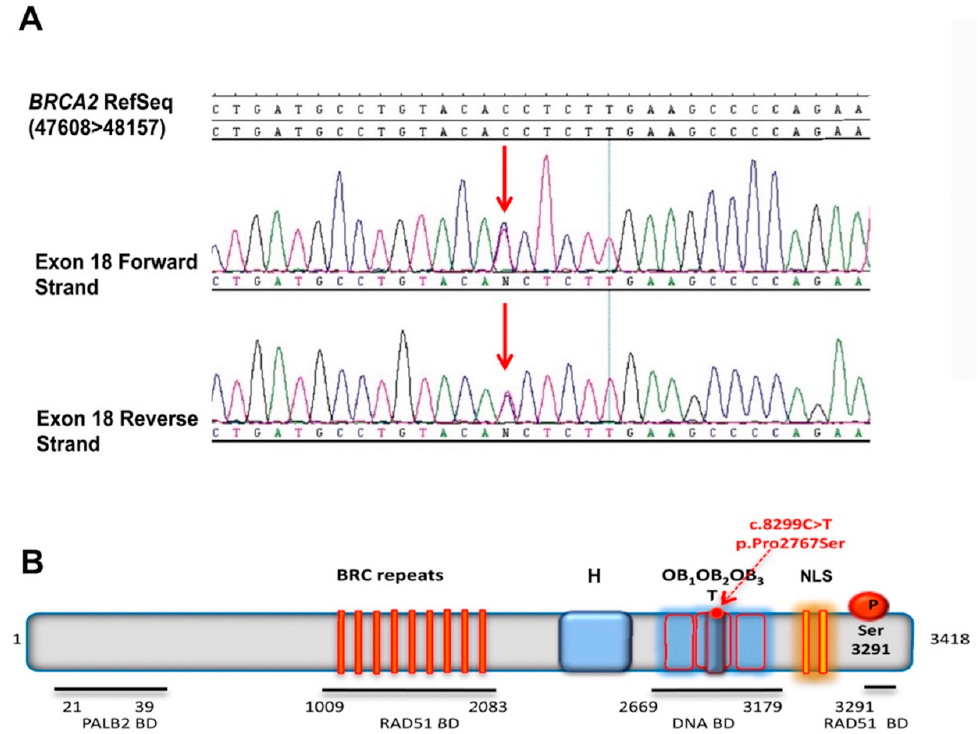
Figure 1. Sanger sequencing of the exon 18 of BRCA2 and BRCA2 full-length protein representation. ( A ) Sanger sequencing of the exon 18 of the BRCA2 gene performed on the patient’s DNA showing the c.8299C > T p.Pro2767Ser variant in the heterozygous state on forward and reverse strands. ( B ) Schematic representation of the full-length BRCA2 protein (3418 aa) with its functional domains. The N-terminal domain (aa 10–39) includes the PALB2 binding domain (PALB2 BD), the eight BRC